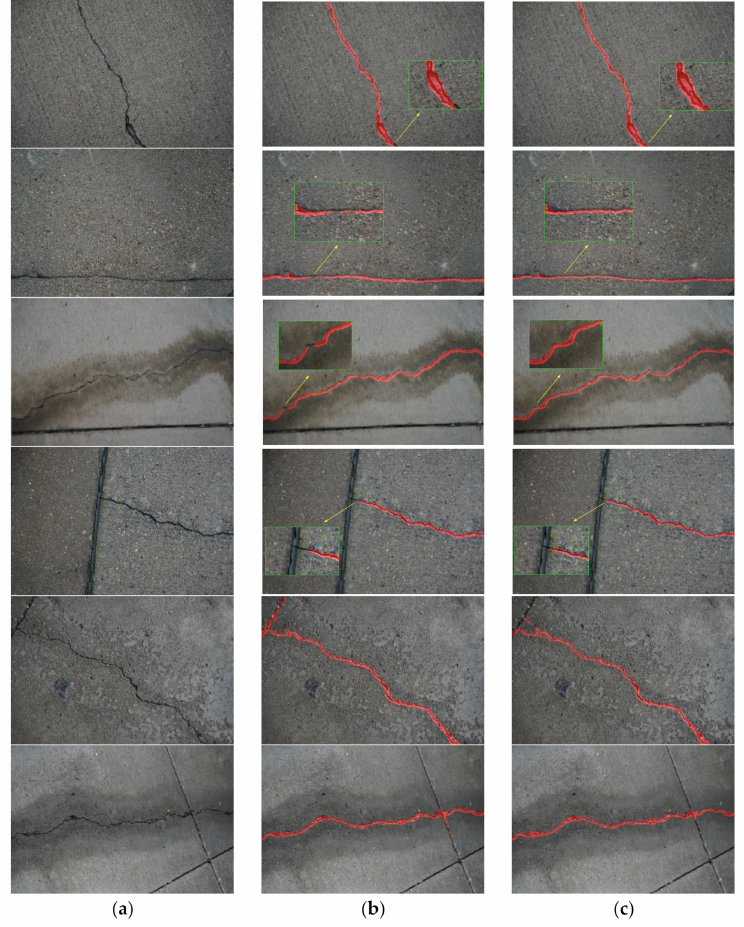
Figure 9. Comparison of original DeepLabv3+ and Dense-DeepLabv3+ crack segmentation results. ( a ) original image ( b ) DeepLabv3+ ( c ) Dense-DeepLabv3+.